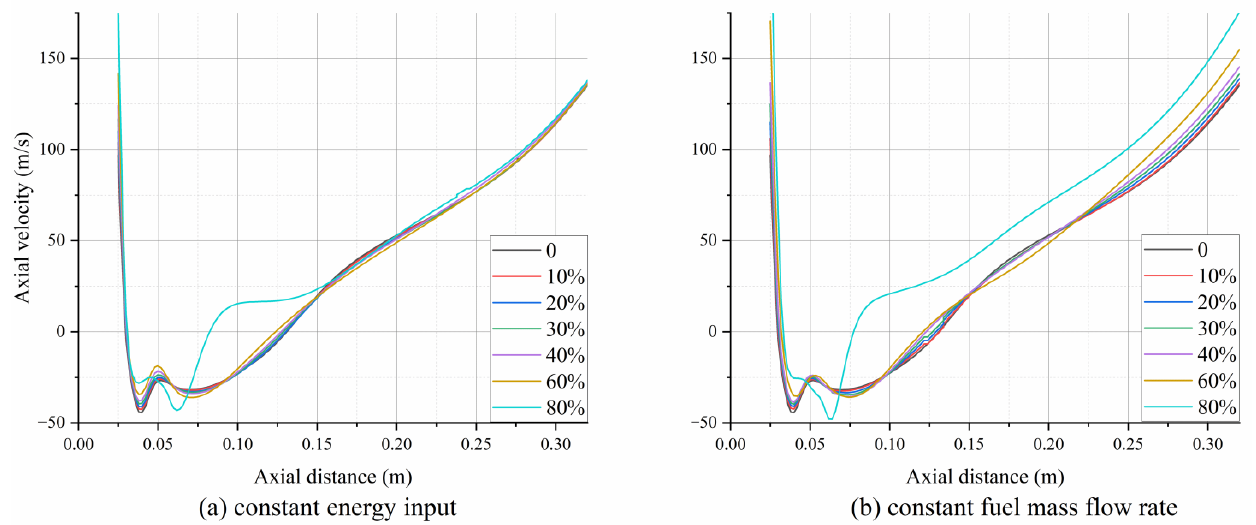
Figure 5. Axial velocity distribution along the central axis. ( a ) constant energy input; ( b ) constant fuel mass flow